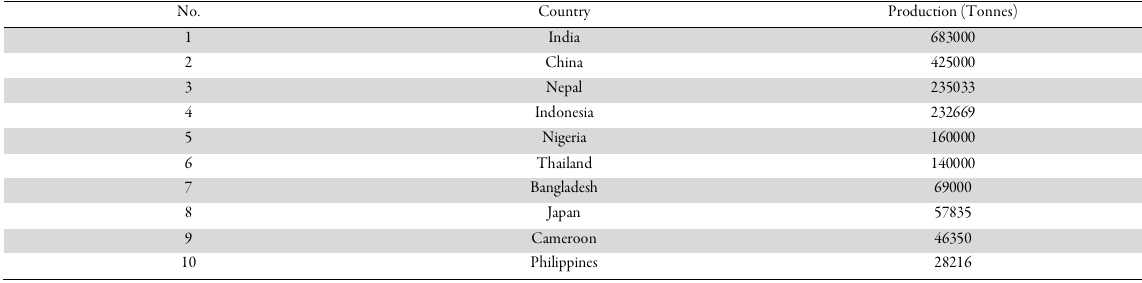
Table 1. Top ten Ginger producing country of the world (Dhanik et al ., 2017)